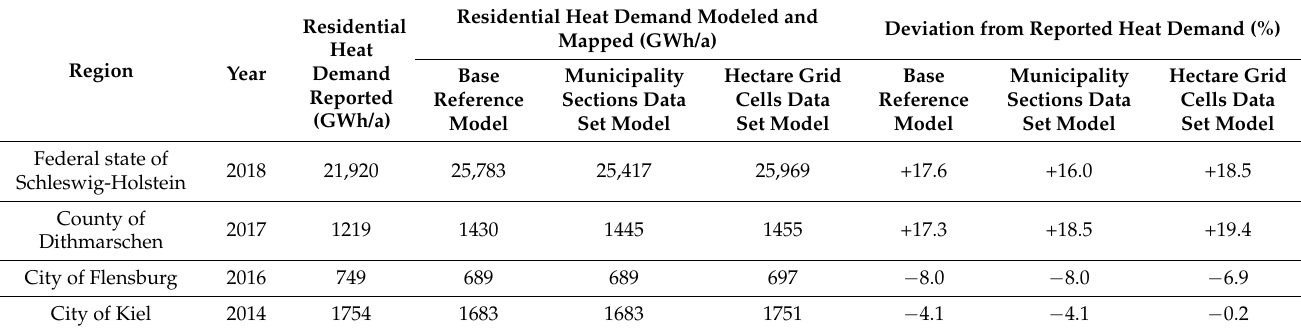
Table 3. Comparison of reported and modelled residential heat demand on different spatial